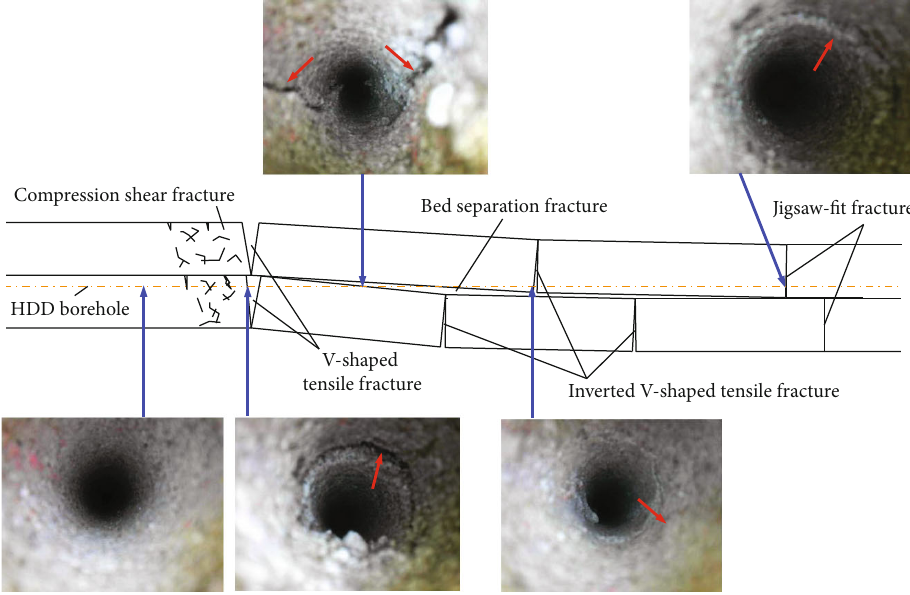
Figure 3: Types of mining-induced fractures exposed by HDD. Note: the photos are of the fractures exposed by the simulated borehole created in the physical simulation discussed in Section